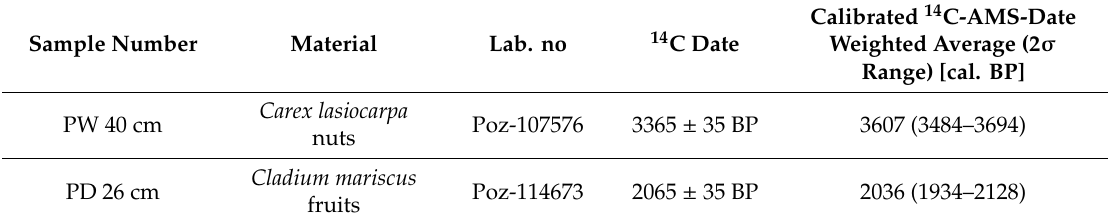
Table 1. Radiocarbon dates in PW and